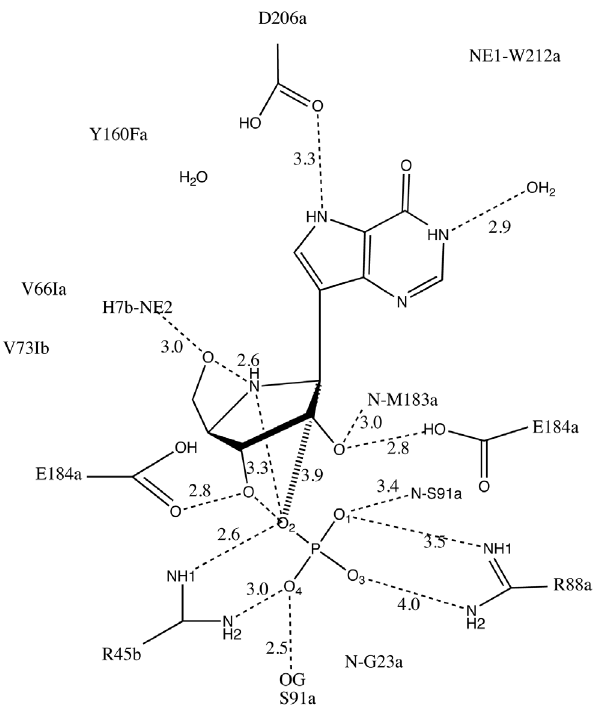
Figure 6. Catalytic site contacts for ImmH and PO 43 2 at the active site of V66I:V73I:Y160F PfPNP. The schematic shows the catalytic site of the triple mutant Val66Ile:Val73Ile:Tyr160Phe PfPNP with ImmH and phosphate in the active site, which is at the interface of 2 subunits within the hexameric structure (a trimer of dimers). Amino acids are from the parent subunit unless labeled with b , which marks residues from the adjacent subunit. Dashed lines indicate hydrogen bonding. Distances are shown in Angstroms.